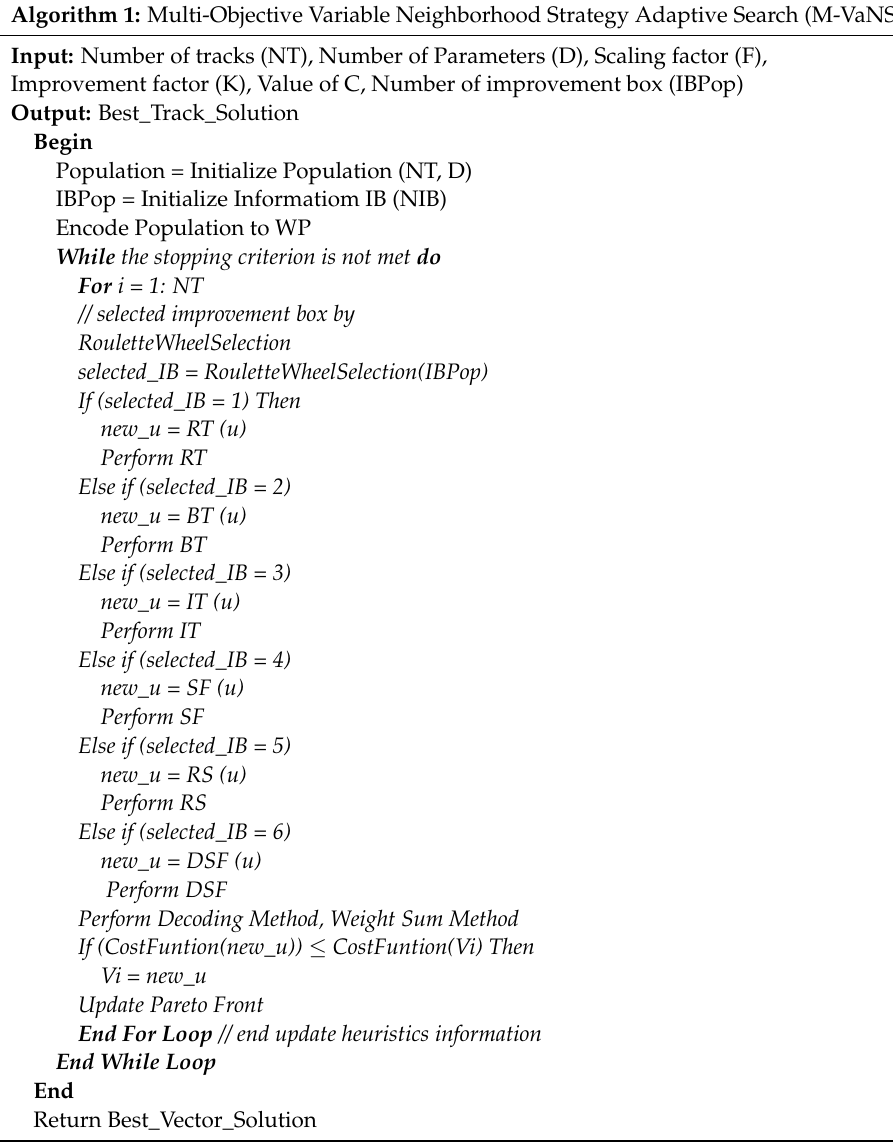
Algorithm 1: Multi-Objective Variable Neighborhood Strategy Adaptive Search